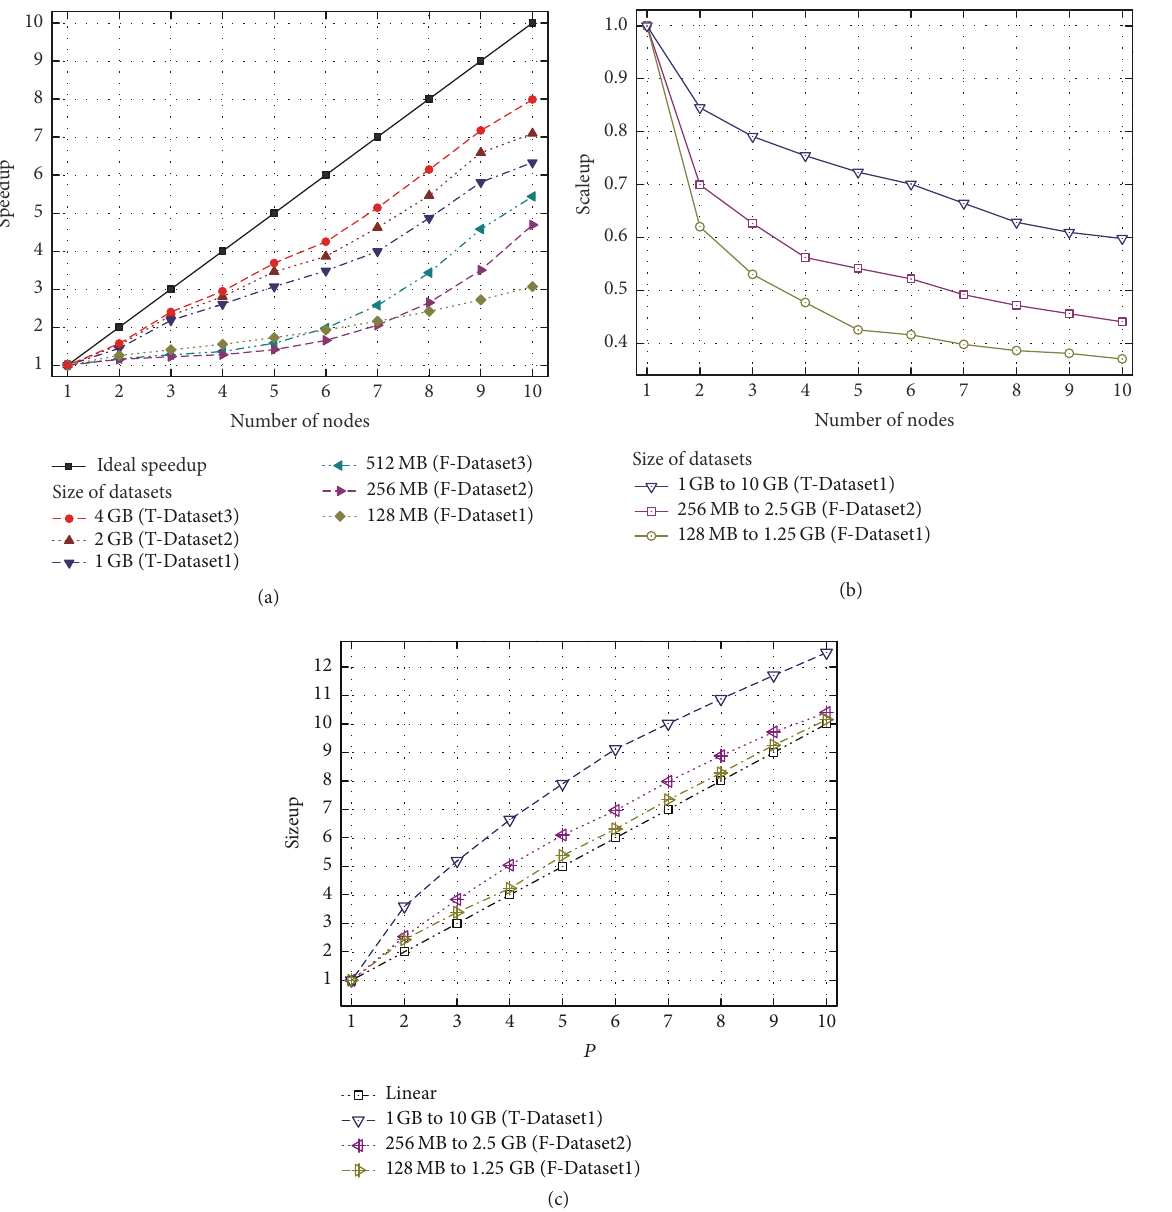
Figure 7: Speedup, scaleup, and sizeup of MR-PFP. (a) Speedup, (b) scaleup, and (c)